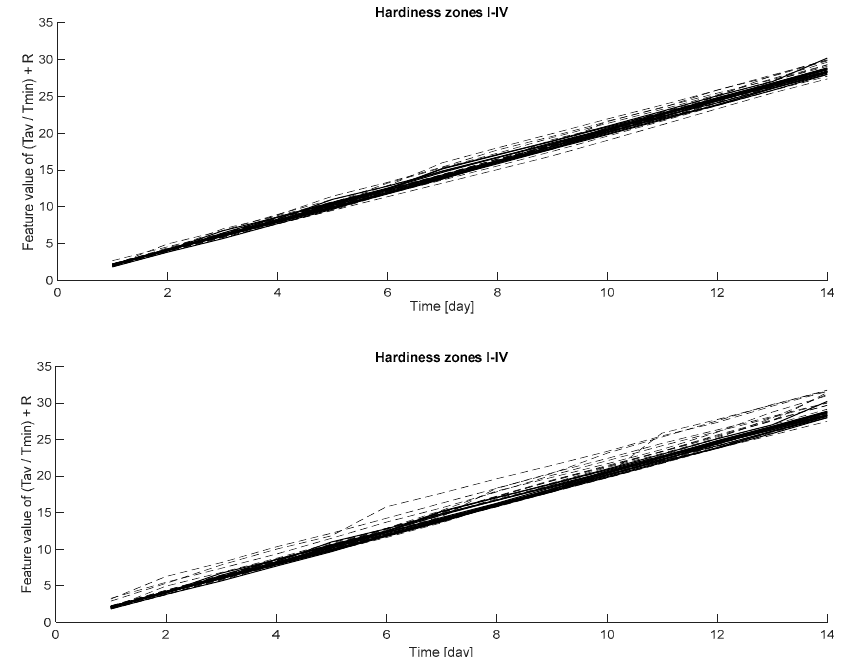
Figure 7. The cumulative summed feature values (y-axis) for the cases’ reference data vs. category 1 data (above) and reference data vs. category 2 data (below). The weather data used included hardiness zones I–IV.